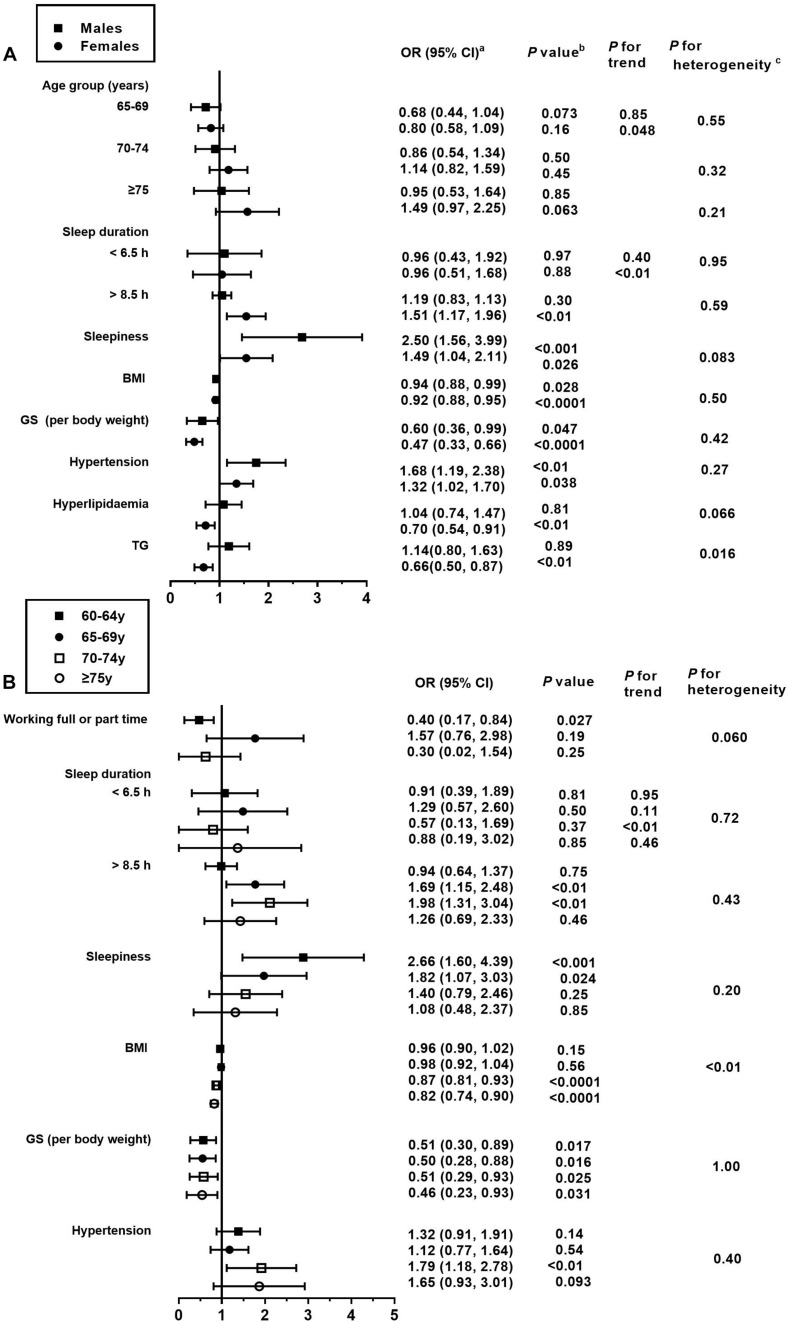
Association between the risk factors and MCI, stratified by sex and age. BMI, body mass index; GS, grip strength; TG, triglyceride. This figure only shows the risk factors that are significantly associated with MCI. For details on the association of all risk factors with MCI, please refer to Supplementary Tables 3, 4. (a) Fully adjusted models are adjusted for age, sex, education level, income status, marital status, employment status, physical activity, smoking status, drinking status, sleep duration, BMI, GS, hypertension, diabetes, hyperlipidemia or its diagnostic indicators, and sleepiness. (b) Obtained using a multiple logistic regression analysis. (c) Comparison between the odds ratios associated with sex (A) and age groups (B) using P for heterogeneity.